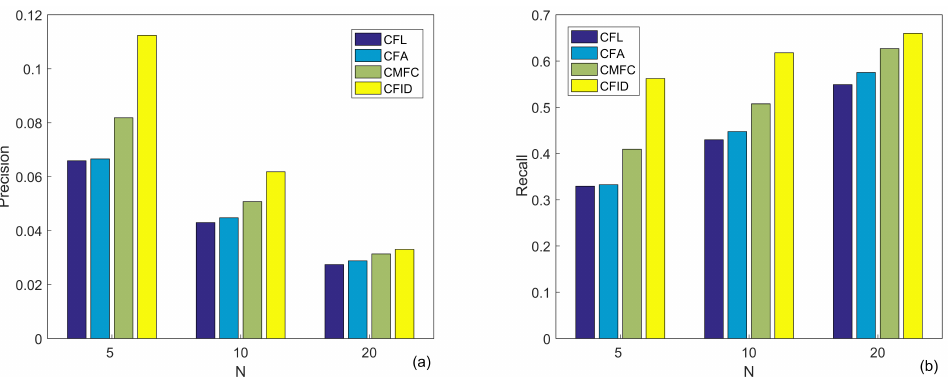
Figure 5. Two-person group recommendation results of four algorithms on New York City dataset. ( a ) precision result; ( b ) recall